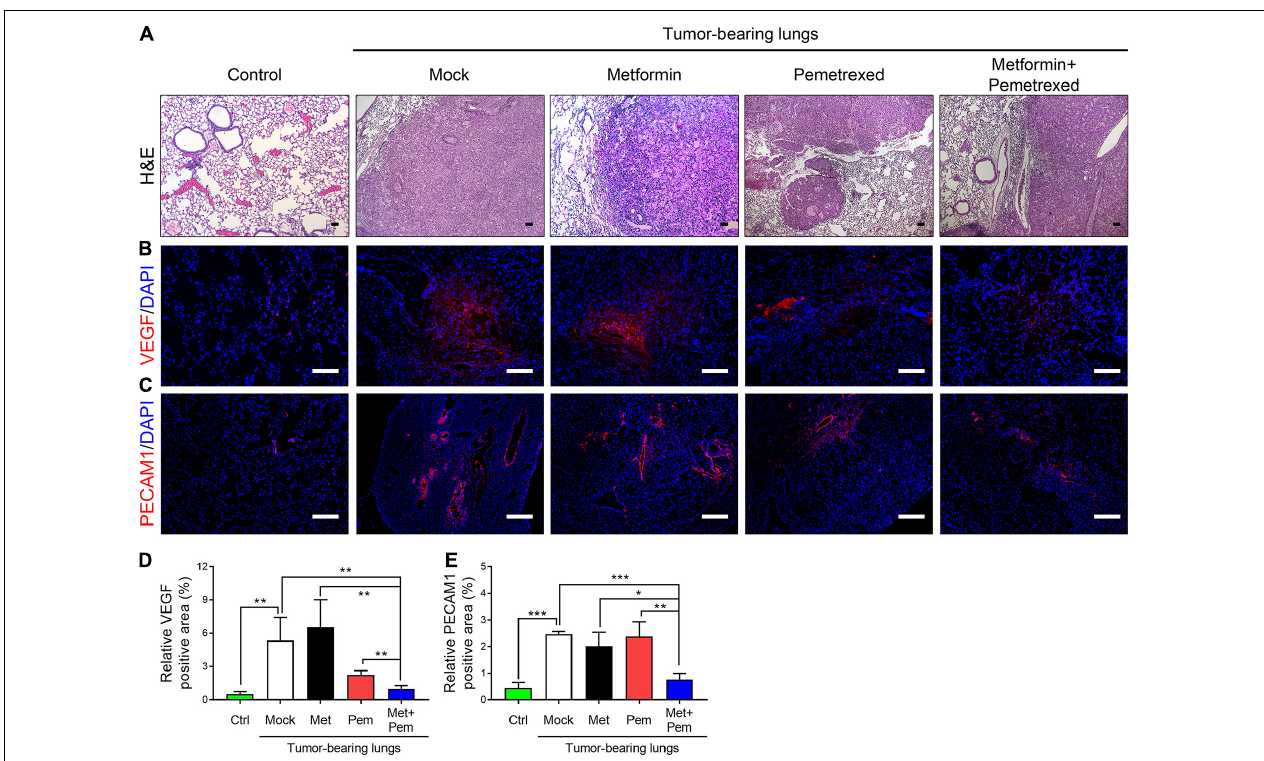
FIGURE 6 | The combination of metformin with pemetrexed exerted additive inhibitory effects on pulmonary tumorigenesis in a human orthotopic NSCLC xenograft model. (A) H&E staining, immunofluorescence staining for (B) VEGF (red), (C) PECAM1 (red) and nuclei (DAPI; blue) in nude mouse lung tissues after a 3 week treatment period with metformin (Met; 250 mg/kg/day), pemetrexed (Pem; 150 mg/kg/twice a week) or both (Met + Pem) following a 4 week A549 cell xenograft. Scale bar = 100 µ m. The area of (D) VEGF and (E) PECAM1 positive signal were calculated in three field from three independent experiments and represented as% of positive area. The data are presented as the mean ± SD of those from 2–3 independent experiments with two technical replicates in each. * P < 0.05, ** P < 0.01, and *** P < 0.001.